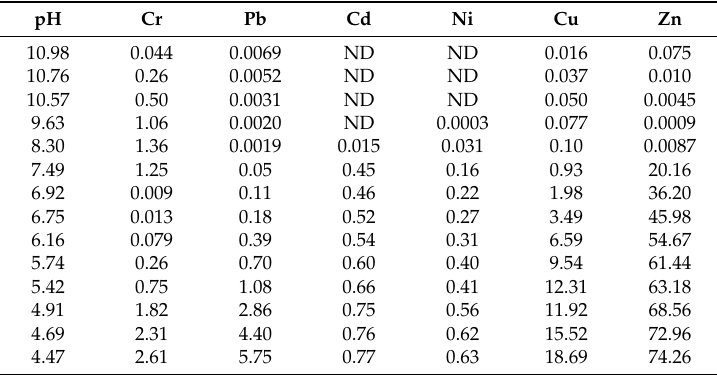
Table 4. Leaching concentration of heavy metals related to pH.